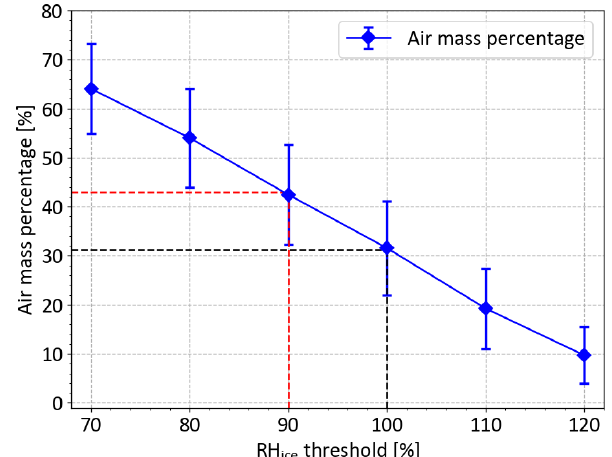
Figure 10. Percentage of air masses as a function of RH ice thresh- olds in the upper troposphere, averaged over the North Atlantic (65– 5 ◦ W) and Europe (5 ◦ W–30 ◦ E) regions for the MOZAIC period from 1995 to 2010. The percentages of air masses above 90% and 100% RH ice thresholds are labelled with the dashed red and black lines,